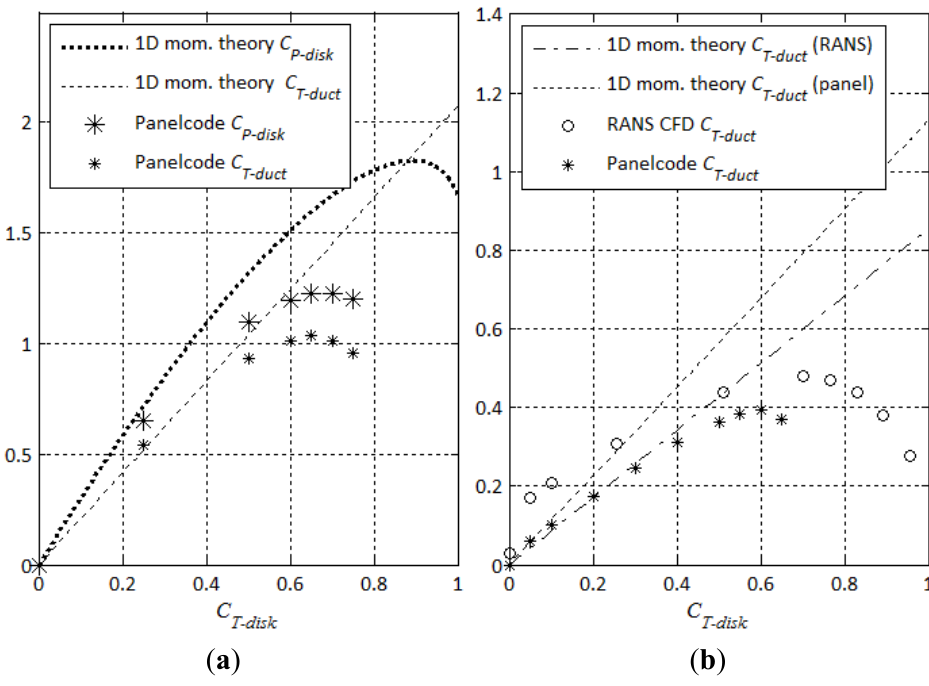
vs. (cid:1829) and (cid:1829) for circular cylinder DAWT ( r R⁄ = 0.15 (cid:3021)_(cid:3031)(cid:3036)(cid:3046)(cid:3038) (cid:3017)_(cid:3031)(cid:3036)(cid:3046)(cid:3038) (cid:3021)_(cid:3031)(cid:3048)(cid:3030)(cid:3047)